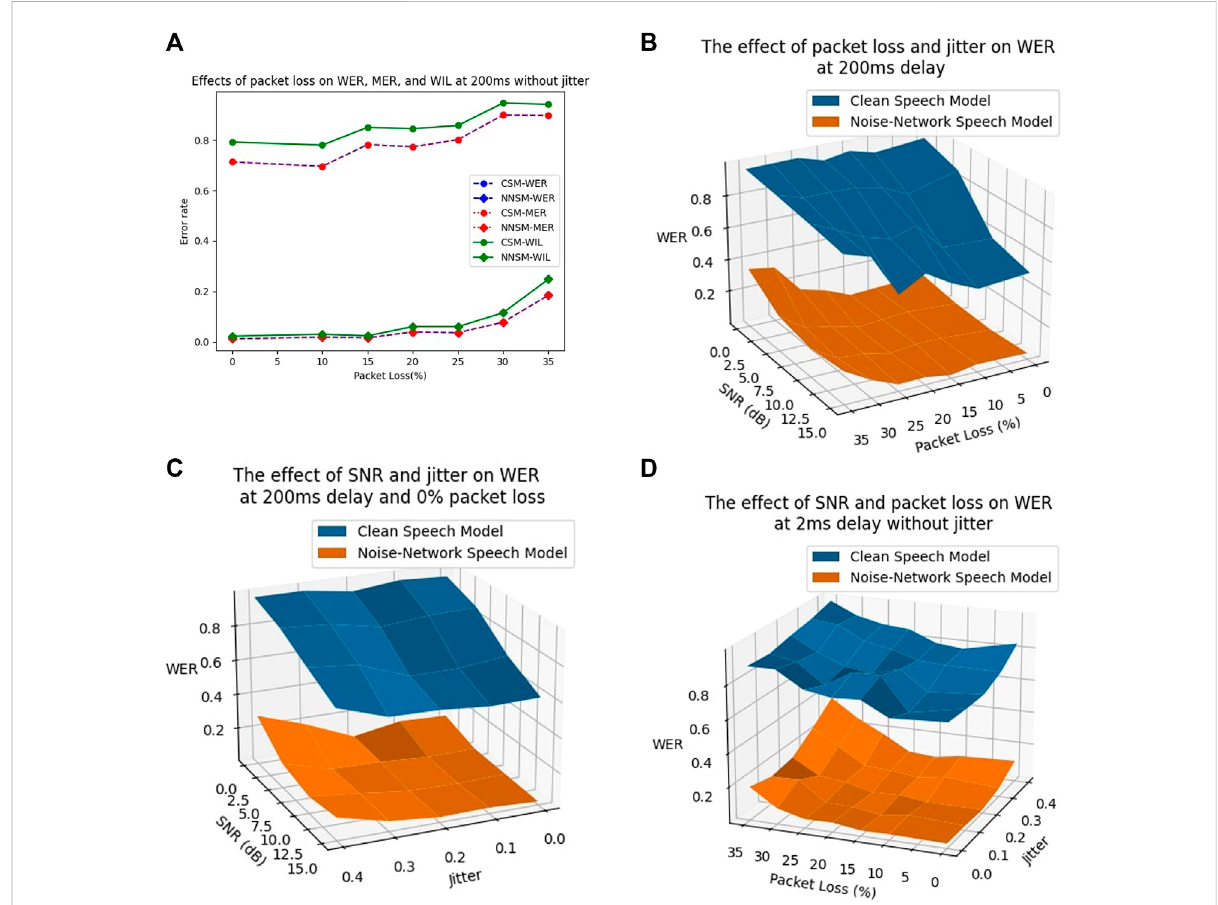
FIGURE 3 The effect of packet loss on WER, MER and WIL, and combination noise-network effects on WER. (A) Effects of packet loss on WER, MER, and WIL, for a constant delay of 200 ms without jitter. (B) Effects of SNR and packet loss on WER, for a constant delay of 2 ms without jitter. (C) Effect of SNRandjitteronWER,foradelayof200mswithpacketlossof0%. (D) EffectsofpacketlossandjitteronWER,foraconstantdelayof200mswithout